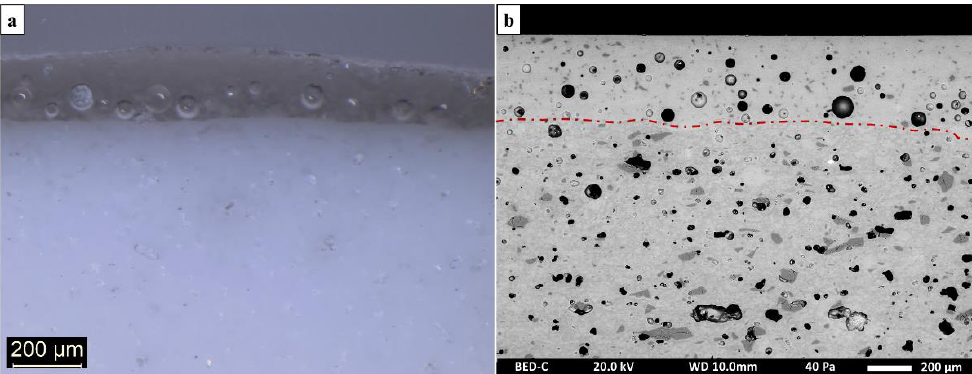
Figure 3. Microphotograph ( a ) and SEM backscattered electron image ( b ) of a porcelain sample. The red dotted line marks the boundary between the glaze and the ceramic support.